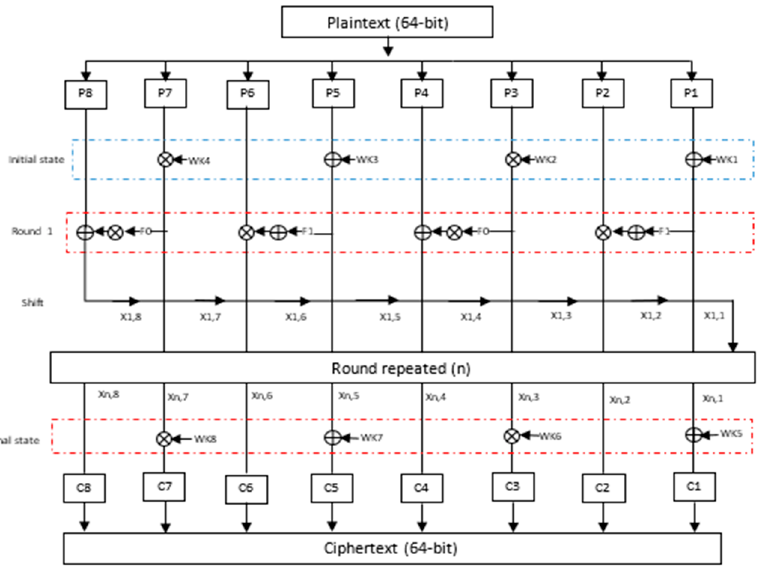
Figure 5. Structure of encryption processes for the proposed MIDEA.